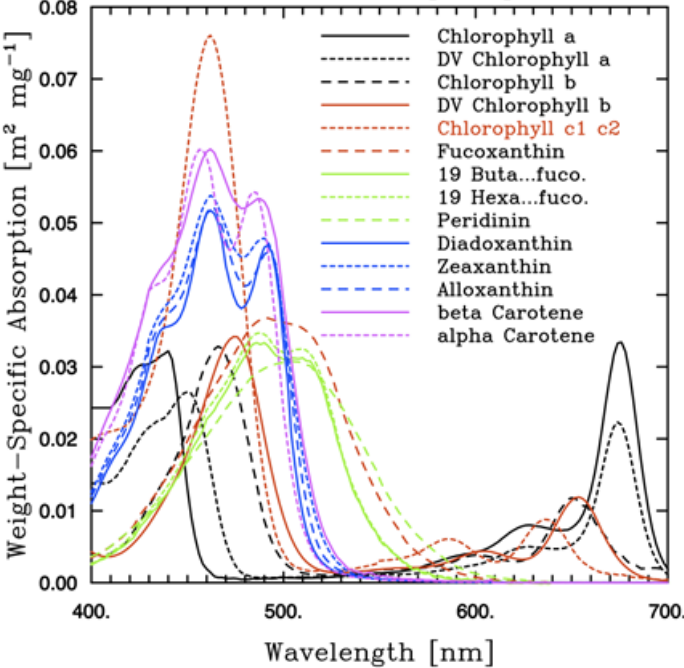
Figure 2. Weight-specific in vitro absorption spectra of various pigments, (cid:1853) (cid:3036)∗ (cid:4666)(cid:2019)(cid:4667) , derived from measuring the absorption spectra of individual pigments in solvent and shifting the maxima of the spectra according to the method described by Bidigare et al. [65]. The spectra were generated using data published by Annick Bricaud